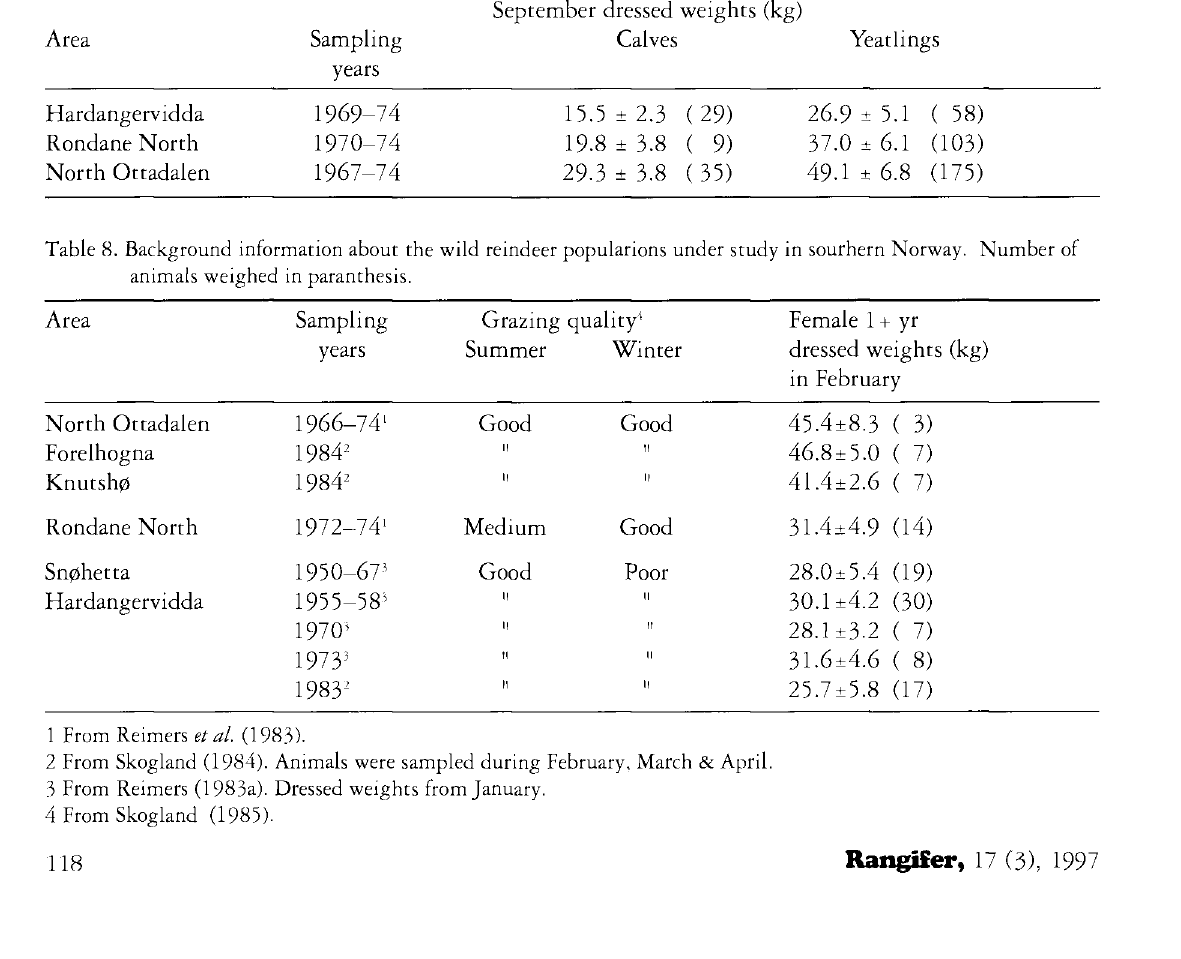
Table 7. Male reindeer dressed weights (DW) ( SD in three wild reindeer areas in southern Norway. Number of ani mals weighed in parenthesis.